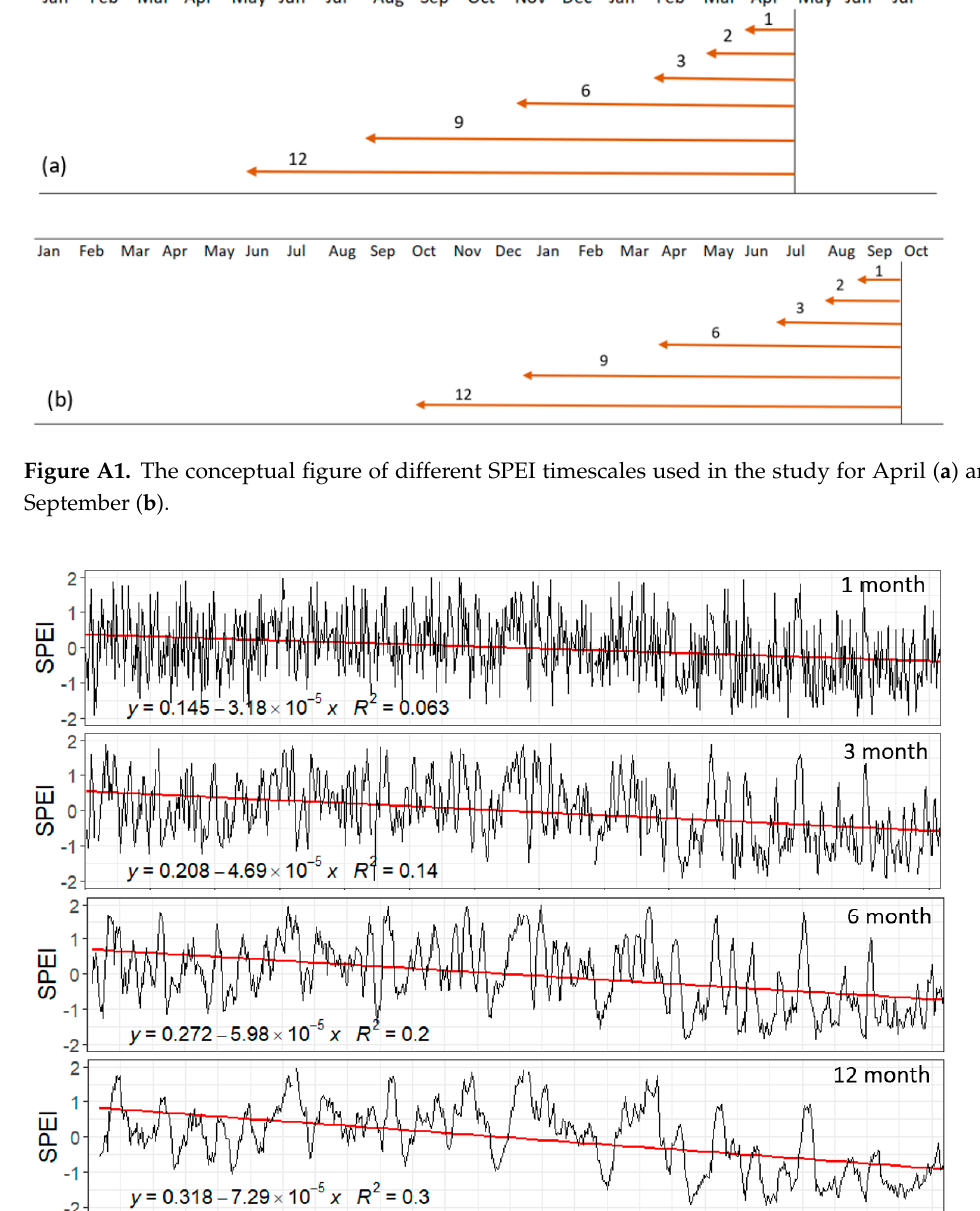
Figure A2. Time series of the spatial mean of 1-, 3-, 6-, and 12-month SPEI timescales for a period of 1950 January to 2015 December significant at p ≤ 0.05 of the Sonoran Desert [31].